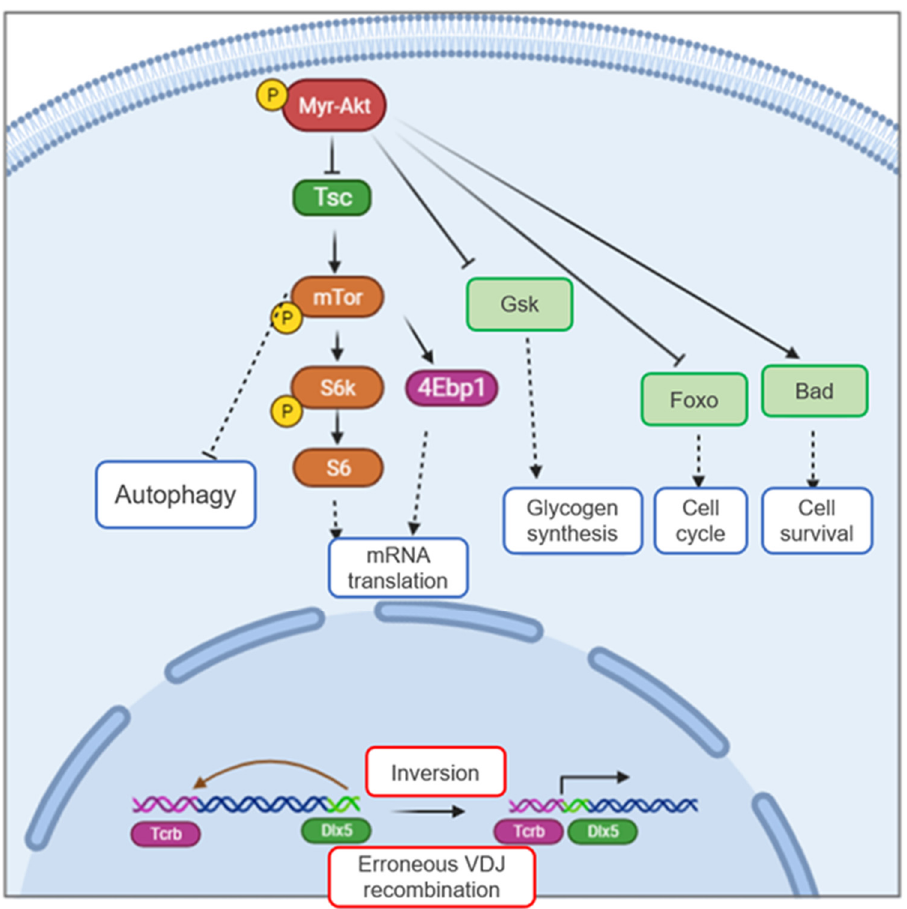
Figure 4. Activation of the Dlx5 gene triggers T-cell lymphoma. Expression of a constitutively acti- vated form of Akt2 (MyrAkt2) in immature mouse thymocytes induces T-cell lymphoma via activation of Dlx5 gene expression, due to a recurrent chromosome rearrangement with Tcrb . Constitutive activation of the Akt pathway promotes survival in cells that undergo aberrant VDJ rearrangement and would otherwise undergo apoptosis, whereas the acquisition of T-cell-specific overexpression of Dlx5 gene provides a proliferative advantage that, together, result in lymphomagenesis.